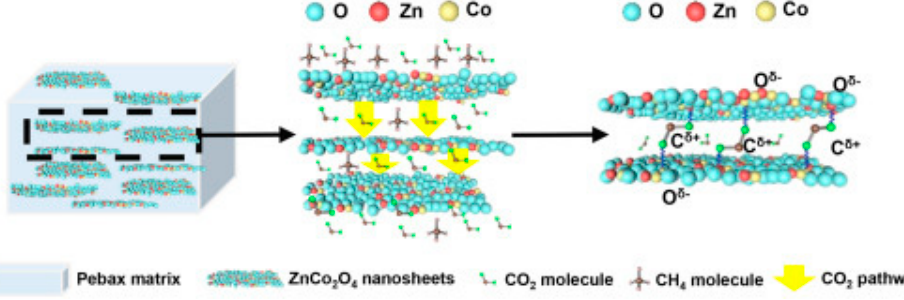
Figure 4. Schematic of the gas transport in MMMs containing 2D porous nanosheets (from ref. [28]). Carbon ‐ Based